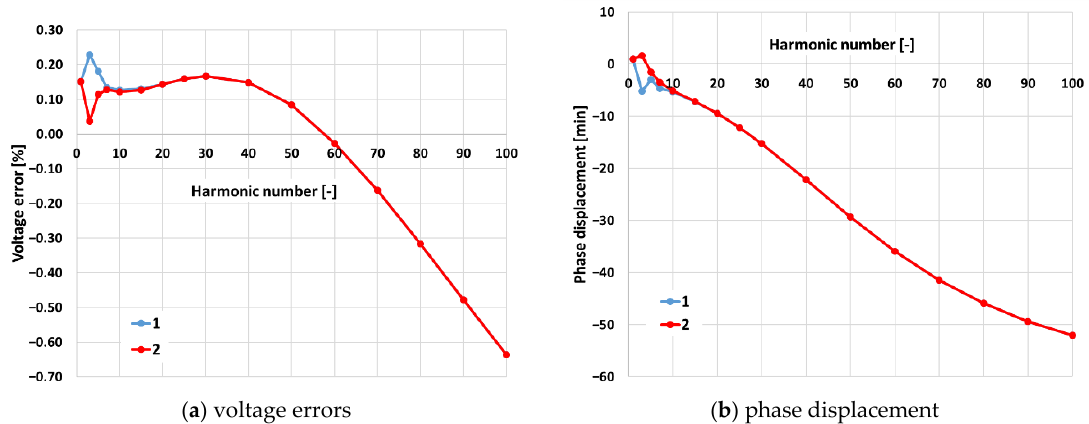
Figure 9. Transformation errors at individual harmonics superimposed on the first harmonic of the rated voltage, supplying the primary winding, measured for the first secondary winding of the tested VT model at different phase shifts between the first and higher harmonics. 1—maximum phase shift between harmonics. 2—harmonics are not shifted.